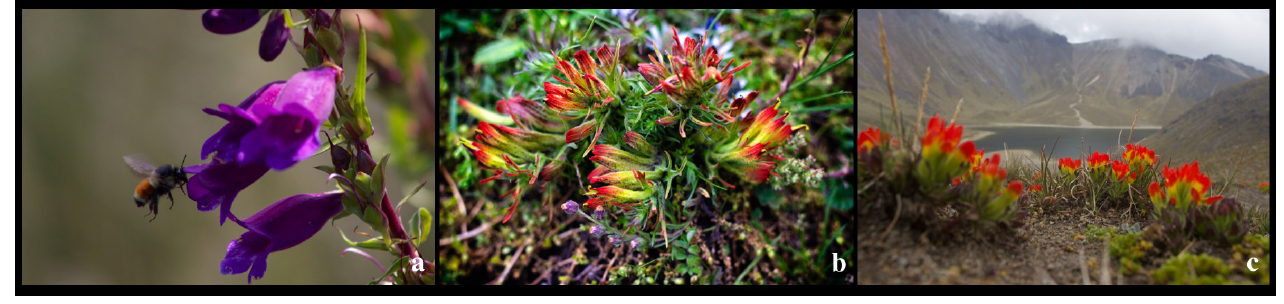
Fig. 2 . Plant species used by hummingbirds in alpine habitats of the Transmexican Volcanic Belt: (a) Penstemon gentianoides at Iztaccihuatl, (b) Castilleja moranensis at Iztaccihuatl, (c) Castilleja tolucensis at Nevado de Toluca. Photographs by Adolfo López